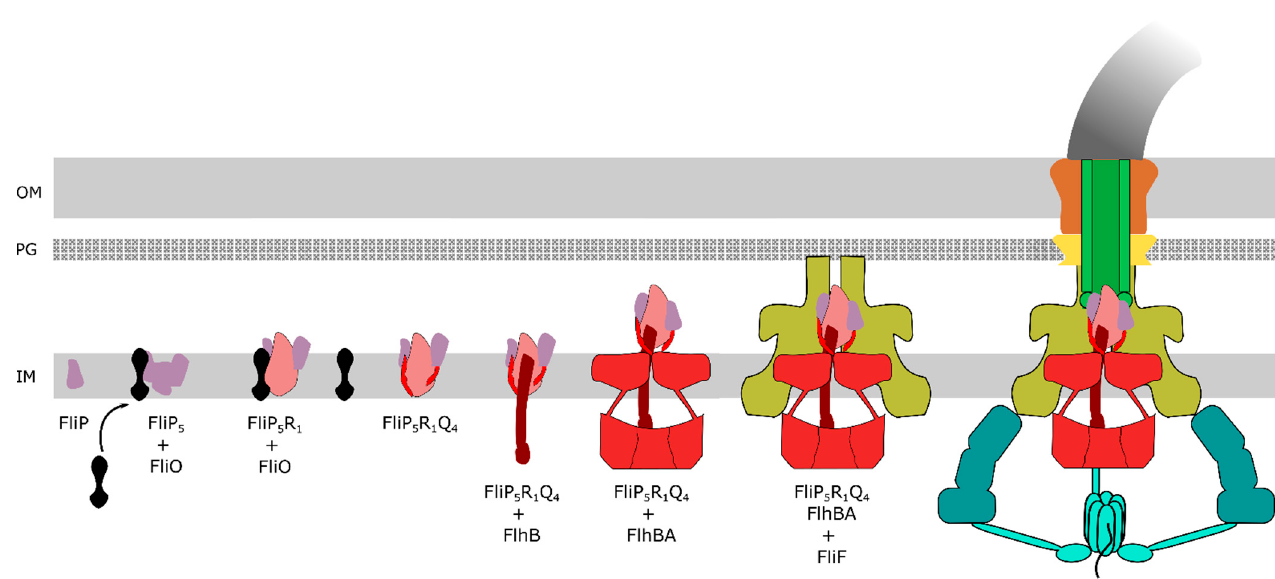
Figure 2. Step-wise export apparatus assembly model. Formation of the FliP 5 complex in the IM is presumably promoted by the integral-membrane chaperone FliO. FliO further facilitates the formation of a stable FliP 5 R 1 complex. Once the FliP 5 R 1 complex is formed, FliO is thought to dissociate from the complex. The FliP 5 R 1 complex then constitutes the nucleus for the assembly of the subsequent subunits of the export gate (FliQ 4 , FlhB and FlhA 9 ). Finally, the MS ring made of FliF forms around the core export apparatus FliP 5 FliQ 4 FliR 1 FlhB 1 FlhA 9 in the IM followed by the assembly of the C ring (made of FliG/M/N) and recruitment of the ATPase complex.